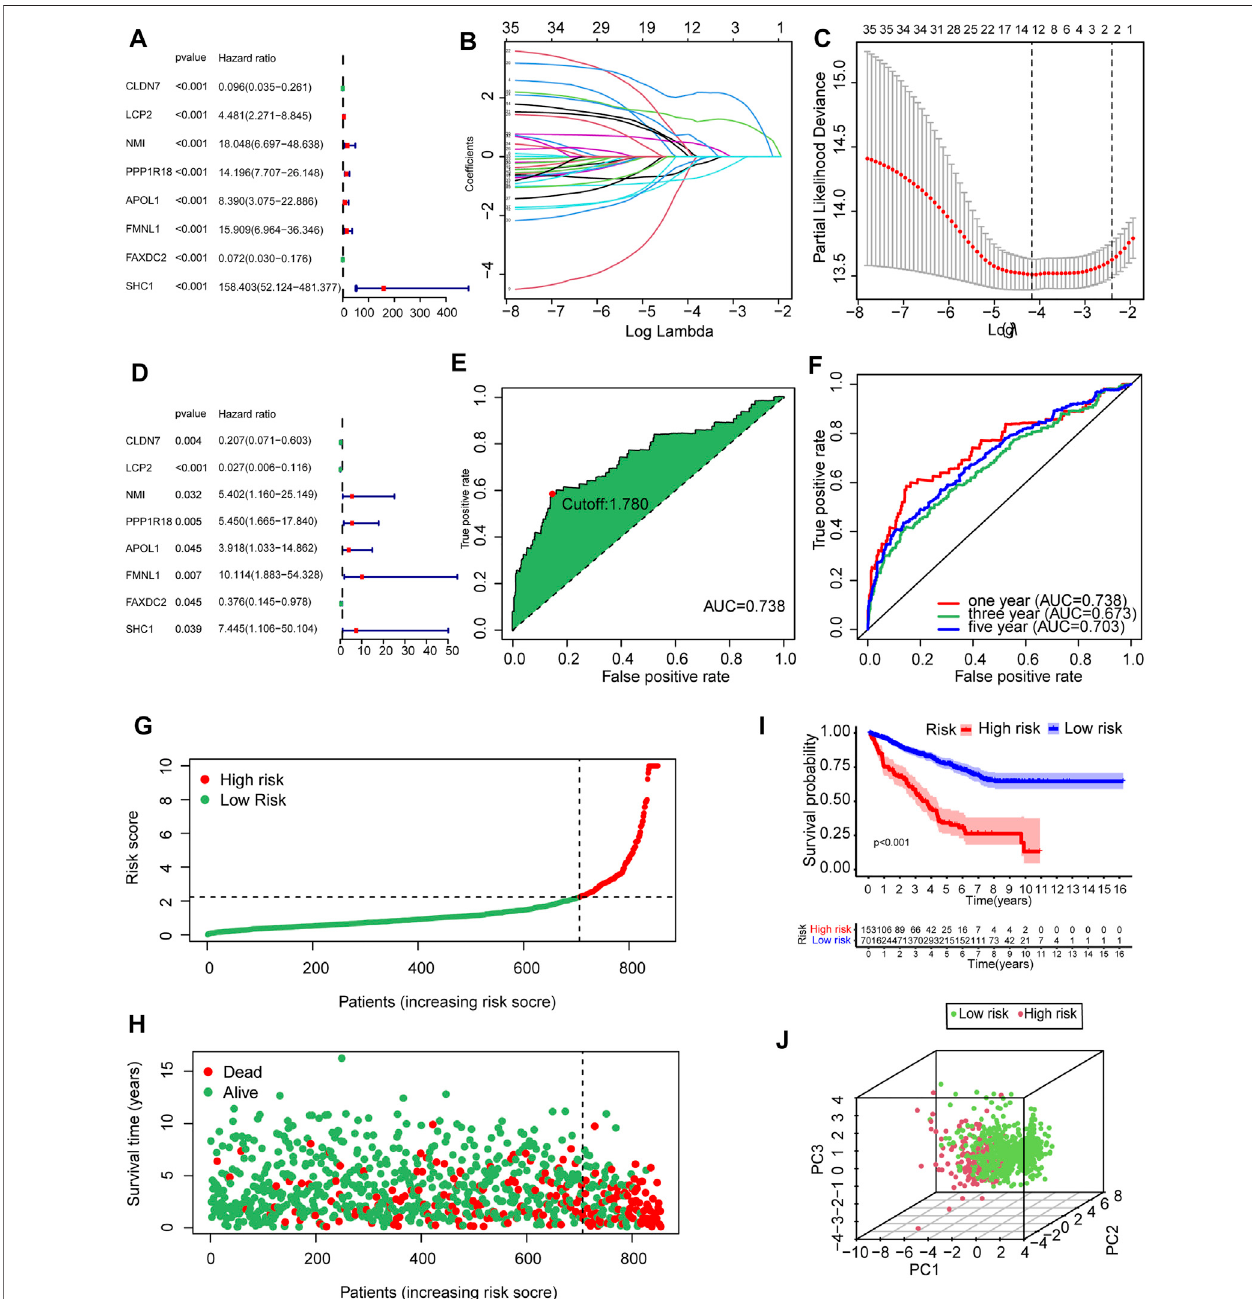
FIGURE 5 | Establishment and validation of the prognostic model based on 146 DEMDGs. (A) The hazard ratios (HR) and 95% con fi dence intervals (CI) of eight DEMDGs in RCC were computed by univariate Cox regression analysis. (B) The changing trajectory of each independent variable. (C) Con fi dence intervals for each optimal lambda. 10-fold cross-validation for the tuning parameter selection in the LASSO model. (D) The HR and 95% CI of eight DEMDGs in RCC were computed by multivariateCoxregressionanalysis. (E) Riskscorefor893RCCsamples;themaximumin fl ectionpointisthecut-offpointaccessedbytheAIC. (F) TheROCcurve for1-,3-,and5-yearoverallsurvival. (G,H) DistributionoftheriskscoresofRCCpatients. (I) Thesurvivalcurveswereplottedtoshowthesurvivaldifferencebasedonthe risk score. (J) Principal component analysis was performed on RCC samples based on risk scores.